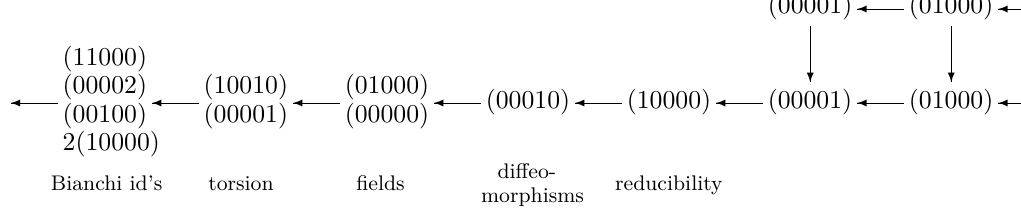
Figure 3 . The complex of E 5 extended